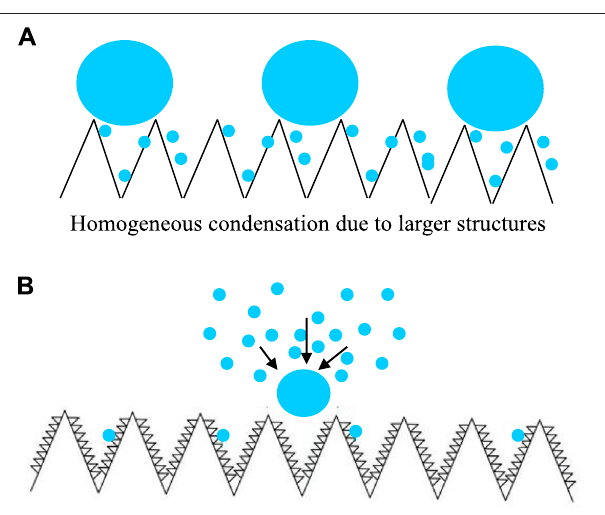
FIGURE 4 | Scheme of water vapor condensation on SHS with submicron rectangle structures (A) , condensate droplets appeared immediately, continuously, and densely, and on the SHS with much smaller nanostructures (B) , condensate droplets appeared tardily, randomly, andsparsely,andthesubsequentcondensationpreferentiallyoccurredonthe nuclei formed earlier, respectively.